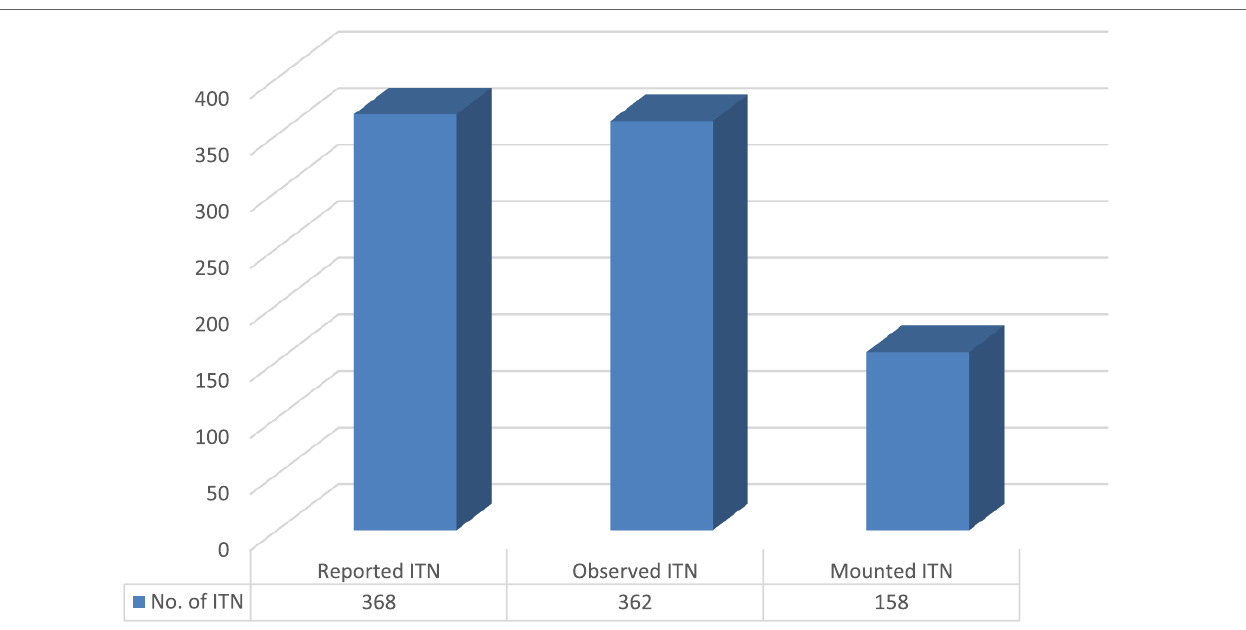
FigUre 1 | The number of insecticide-treated mosquito nets (ITNs) reported, observed, and mounted in the households of Mirab Abaya District, Gamo Gofa Zone, Southern Ethiopia, August–September,